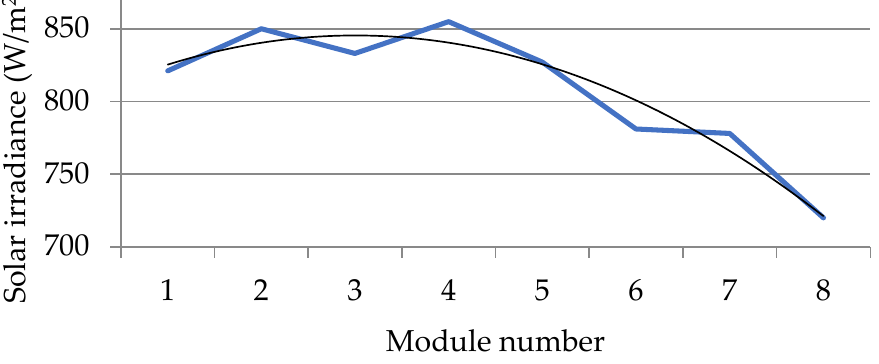
Figure 24. Graphical representation of the solar irradiance over thermographic measurements on the modules. The graphical representation of solar irradiance over the thermographic measurements must be corrected in order to get precise data according to (1), using the data presented in Figure 25. The average wind speed for the studied location in September is 1.7 m/s, based on the Croatian Meteorological and Hydrological Service